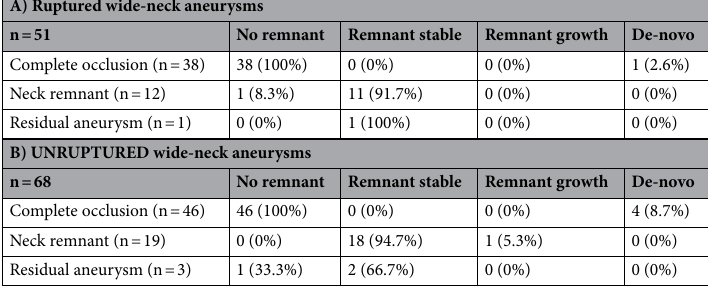
Table 5. Follow-up analysis after microsurgical treatment.